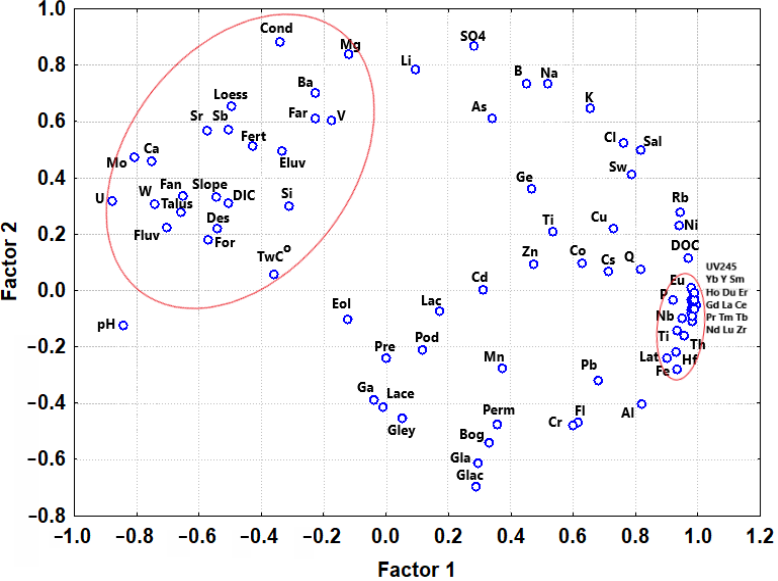
Figure 7. Results of the PCA treatment of all of the dataset (the Ob River main stem and tributaries), including the elementary composition of the river water and landscape parameters of the watersheds. The landscape parameters (% of watershed coverage) are abbreviated as follows: For, Forest; Fl, floodplain; Perm, permafrost; Far, farmland; Pre, pre-Quaternary deposits; Glac, glacial deposits; Slope, slopewash deposits, Des, deserptium (rock stream deposits); Lac, lacustrine and glacio-lacustrine deposits; Fan, fan-alluvial deposits; Gla, glacial deposits; Eol, eolian deposits; Pod, podsols; Sal, saline soils; Fert, fertile soils; TwC°, Water temperature; Cond, Specific Conductivity.